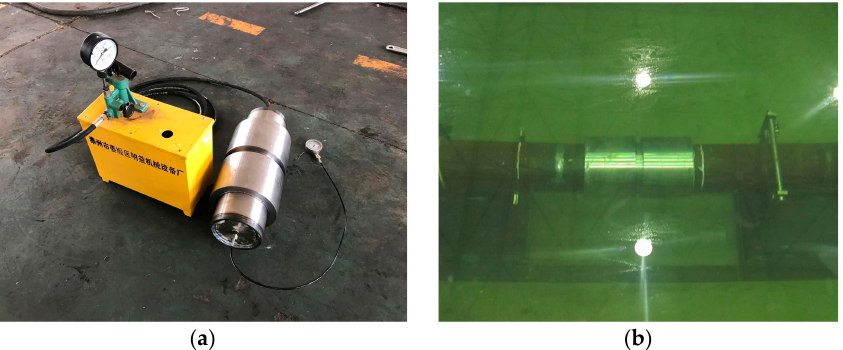
Figure 21. Experiment setups with assemblies of ( a ) hydraulic pressure test and ( b ) air pressure test.